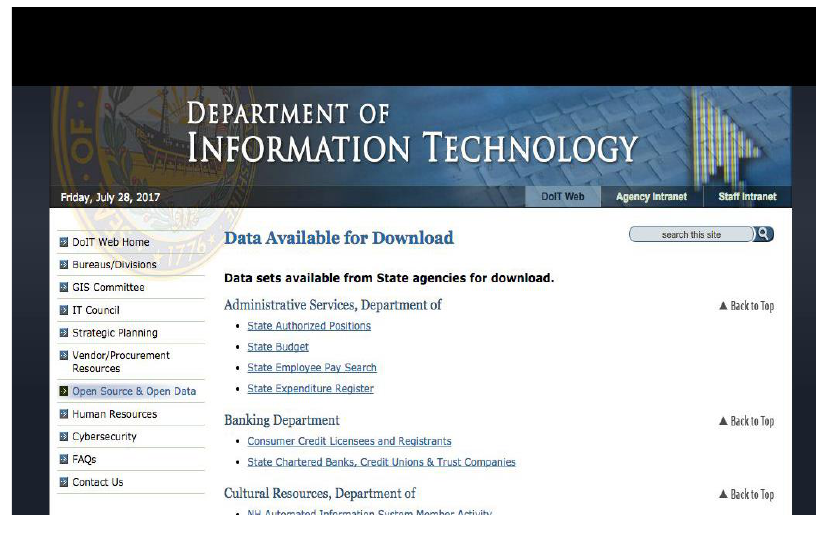
Figure 3: New Hampshire open data web page, July 2017